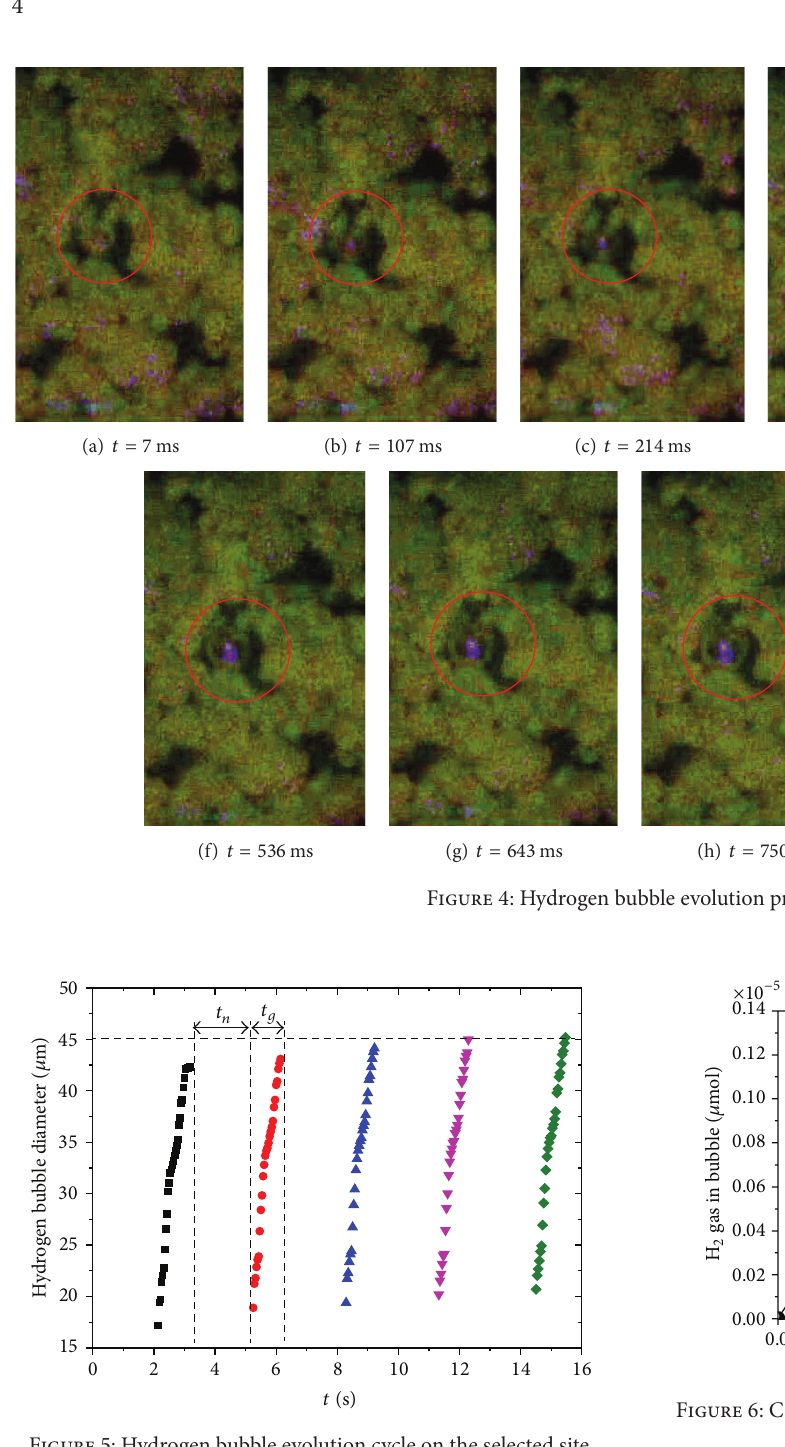
Figure 5: Hydrogen bubble evolution cycle on the selected site.